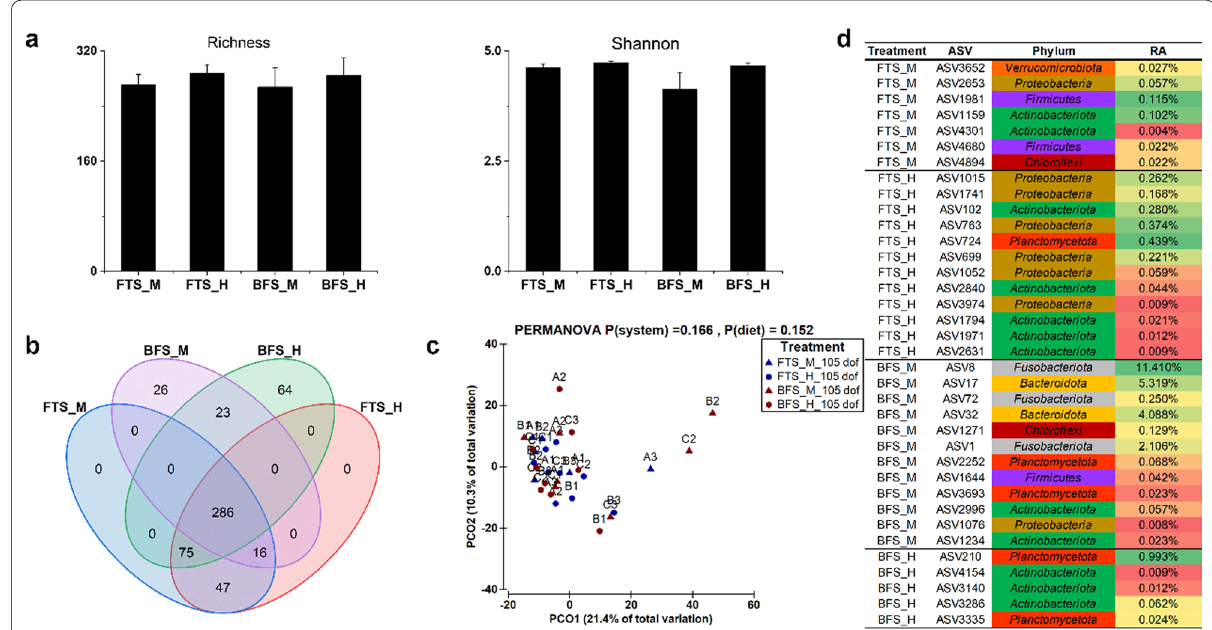
Fig. 4 The diversity of fish gut microbiome at 105 days of feeding (dof). a Alpha diversity (richness and Shannon diversity index) of gut microbiome. Values are presented as mean standard error, the absence of letters above error bars indicates no significant differences between the ± four treatments. b Venn diagram showing the shared amplicon sequence variants (ASV with prevalence > 33% in each treatment) between the gut microbiome from the four treatments. c Principal component analysis (PCoA) showing the distribution of gut microbiome from the four treatments, P values were calculated based on two-way PERMANOVA. Capital letters refer to replicate tanks (A, B. C), numbers refer to fishes sampled for gut microbiome per tank (1, 2, 3). d Heatmap showing the relative abundance (RA) of the indicator species selected from the four treatments, indicator species are coloured according to their phylum taxonomy. FTS flow-through system, BFS biofloc system, M moderate NSP diet, H high NSP